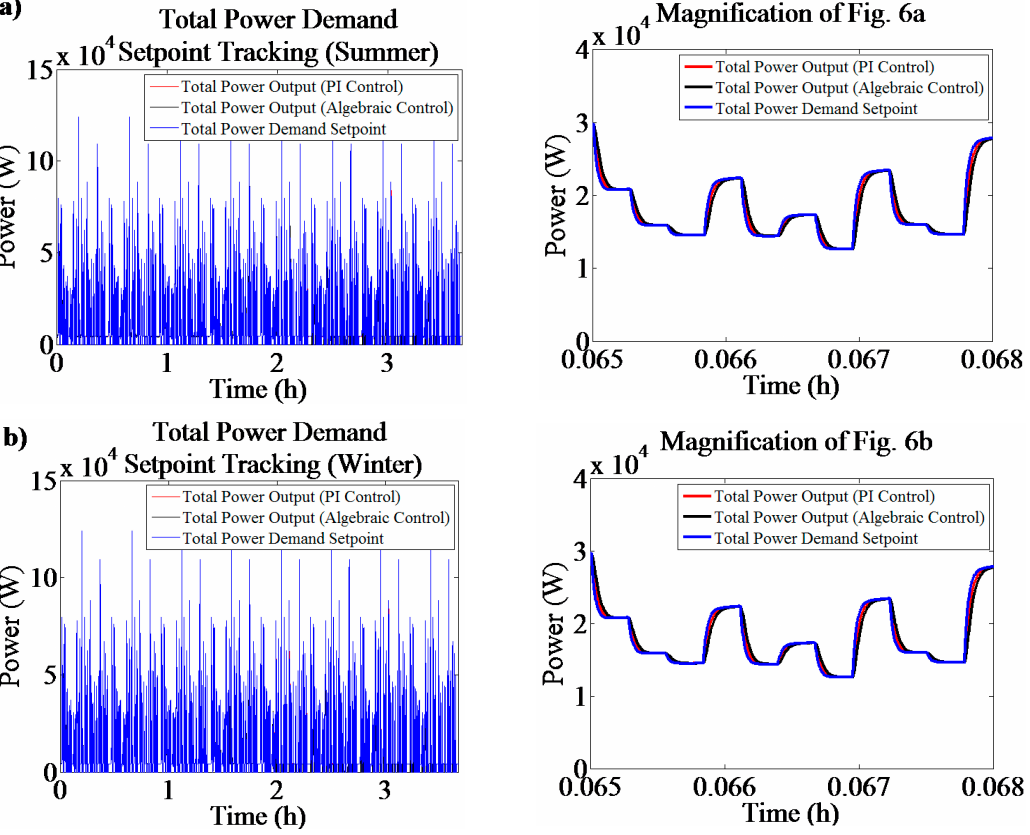
Figure 6. Total power demand set point tracking for the bus using the algebraic and PI control strategies: ( a ) summer operation and ( b ) winter operation. The magnified plots show details of controller performance, how rapid changes in bus speed (hence power demands) were tracked reasonably well.